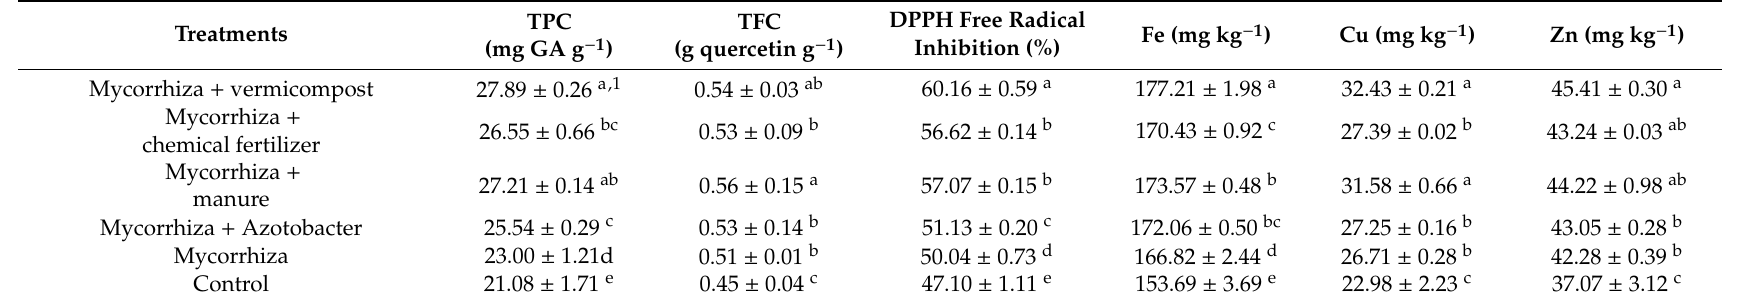
Table 6. Antioxidant properties and trace elements concentrations of Syrian cephalaria as influenced by organic and chemical fertilizers. Treatments